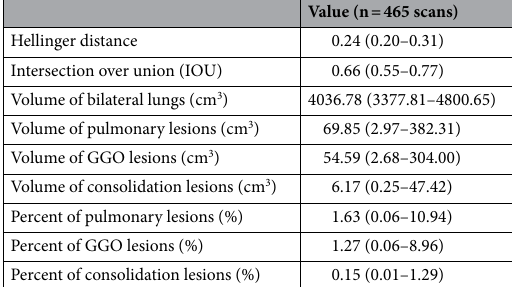
Table 2. The results of deep learning-based quantification.